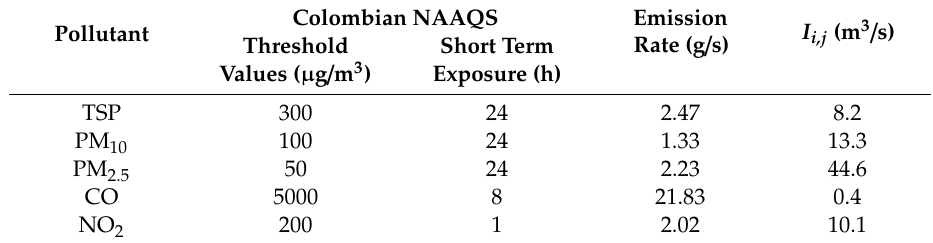
Table 4. Colombian NAAQS [31], emission rates for a burning rate of 1 ha / day, and risk indexes calculated for the case of the agricultural burning of sugarcane crops ( j =